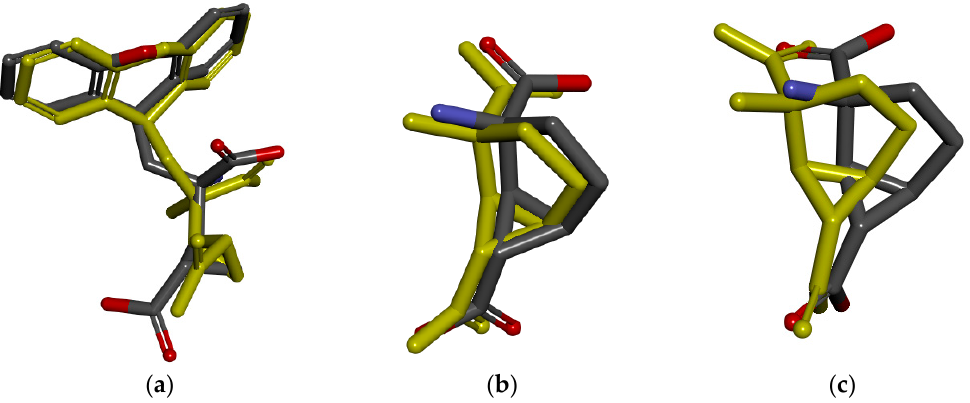
Figure 4. The comparison between the initial binding pose (yellow) and the docked pose. ( a ) mGluR1; ( b ) mGluR2; ( c ) mGluR3.